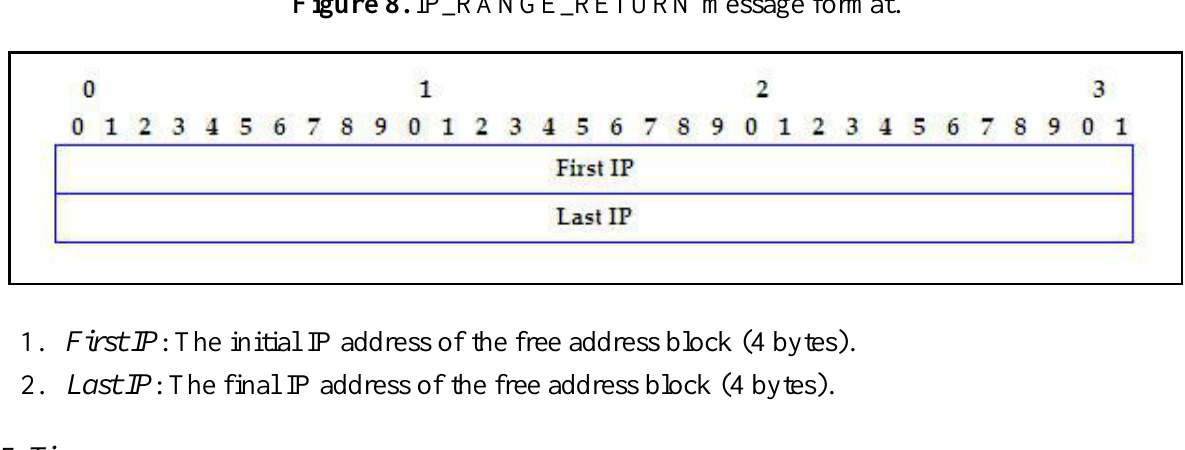
Figure 8. IP_RANGE_RETURN message